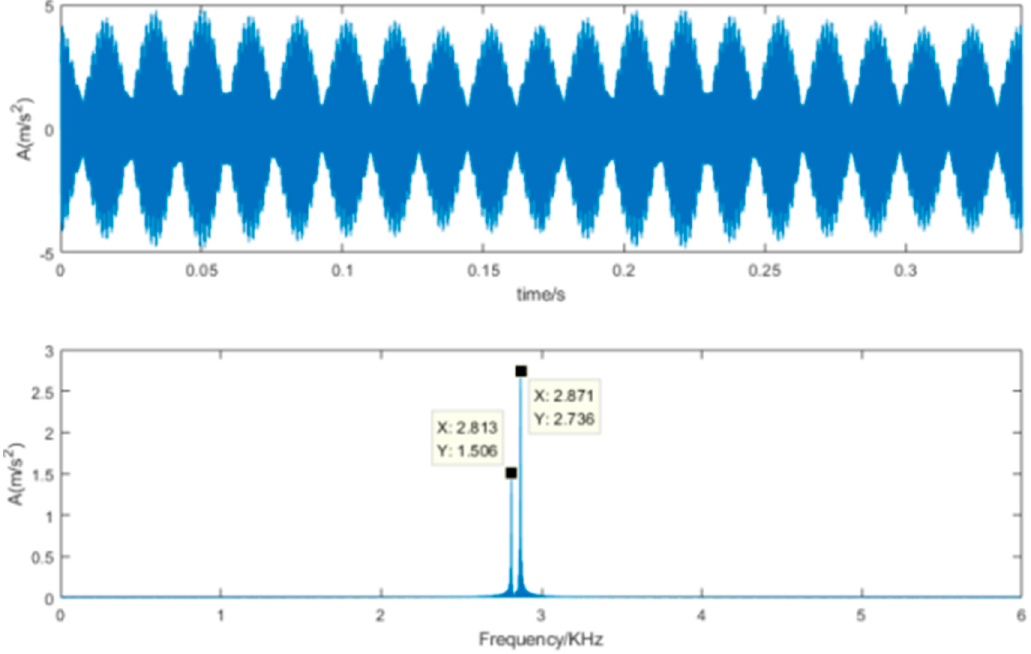
Figure 10. Time-domain waveform and frequency spectrum of denoised signal using SVD-VMD. ( a ) Time-domain waveform of denoised signal using SVD-VMD; ( b ) Frequency spectrum of de- noised signal using SVD-VMD; ( c ) Frequency spectrum limited in 0.9 KHz of denoised signal using SVD-VMD.